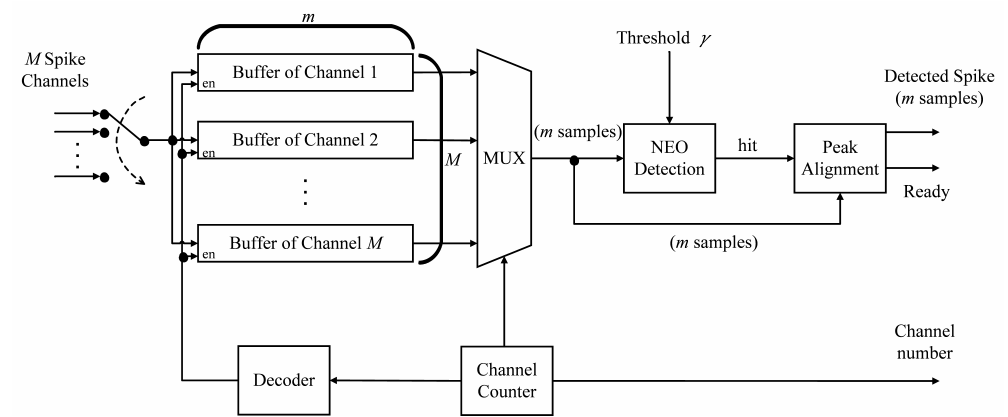
Figure 2. The block diagram of the spike detection circuit. It mainly contains a mixed mode circuit for spike sampling and multiplexing, a channel buffer for storing the spike samples, an NEO detector and a circuit for peak